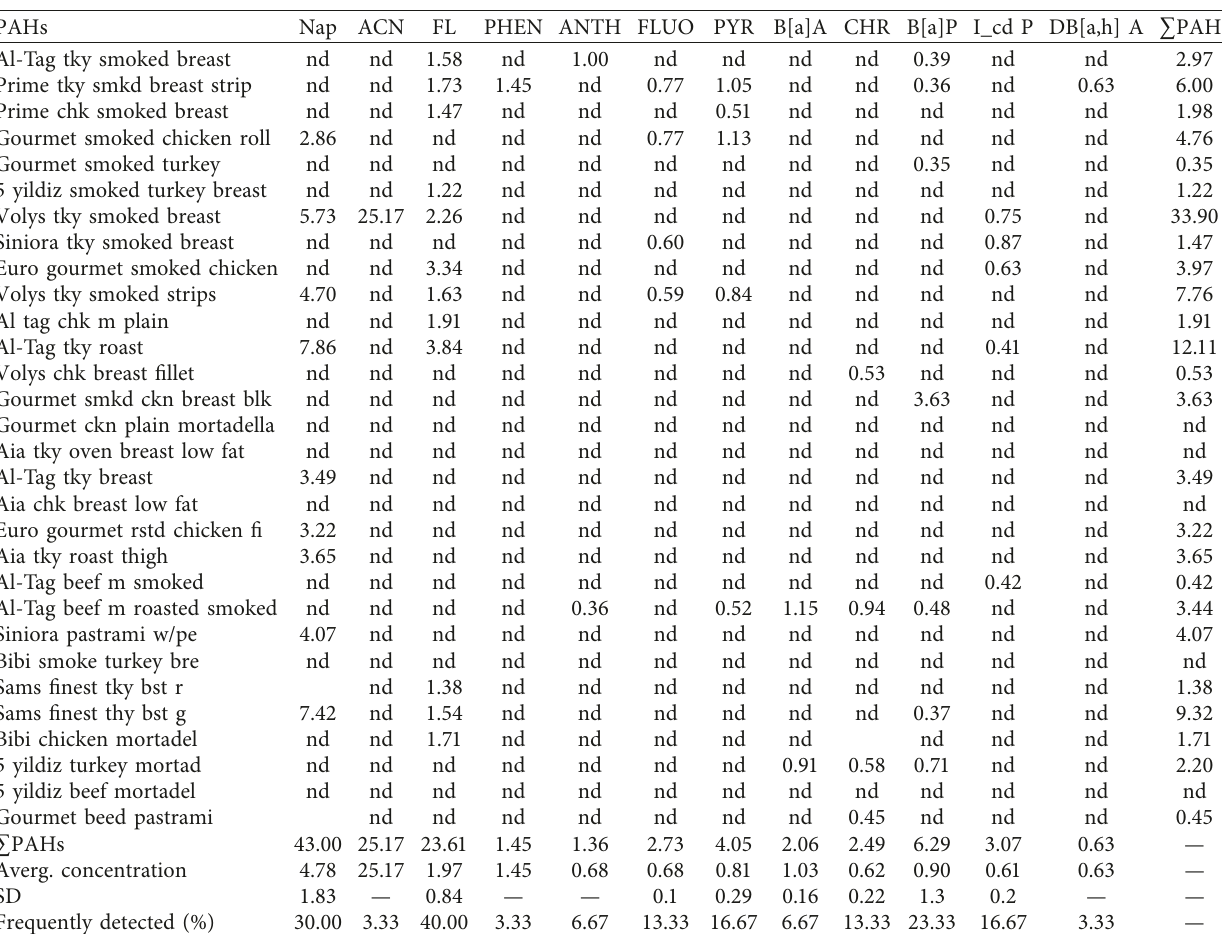
Table 4: : Levels of individual PAHs detected in different samples (ng/g) ( n � 2).